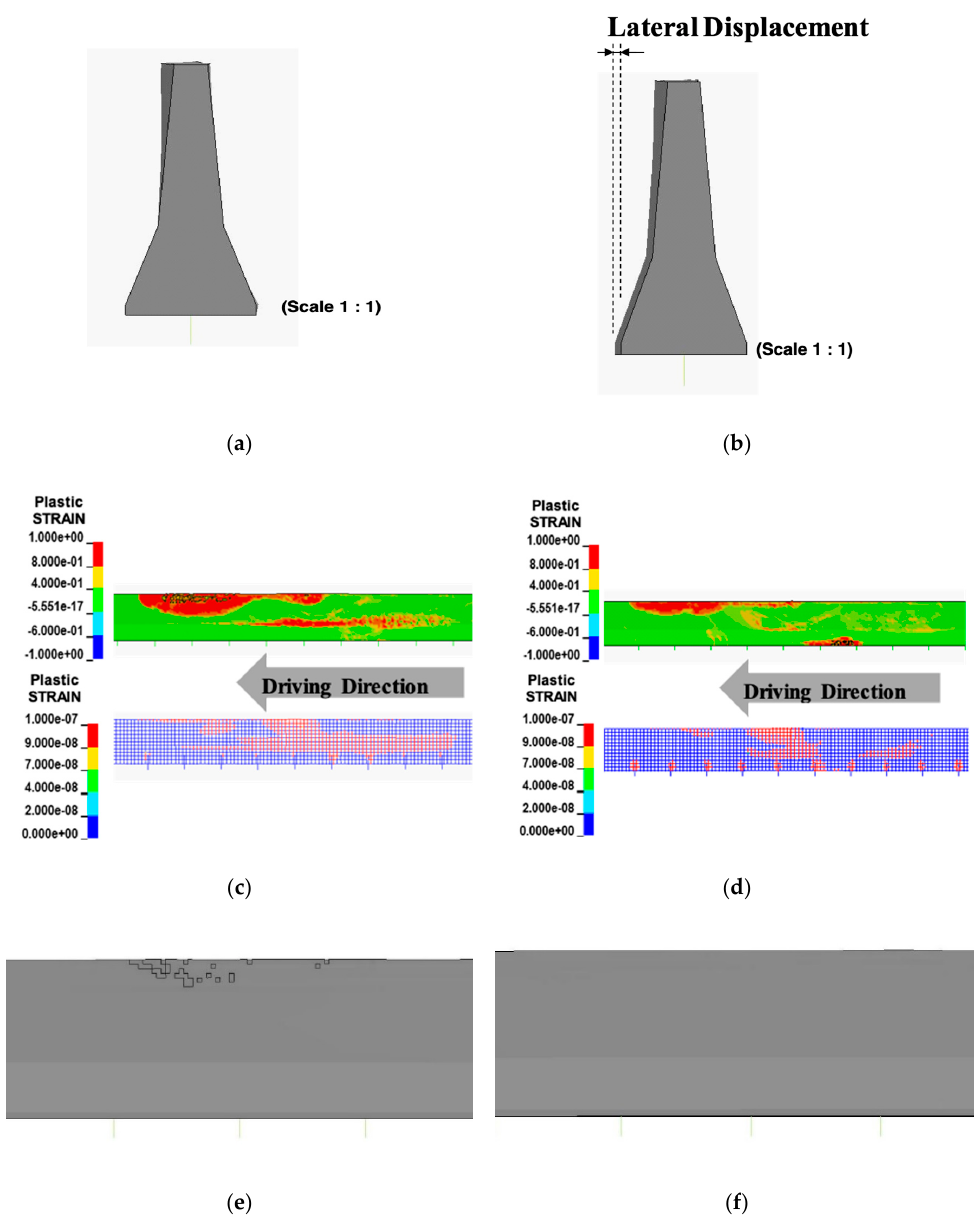
Figure 3. A comparison of deformable concrete median barriers (CMBs) (with shock absorbers) with an ordinary CMB (without shock absorbers). ( a ) Lateral displacement without shock absorbers; ( b ) lateral displacement with shock absorbers; ( c ) longitudinal length without shock absorbers; ( d ) longitudinal length with shock absorbers; ( e ) volume loss without shock absorbers; ( f ) volume loss with shock absorbers.